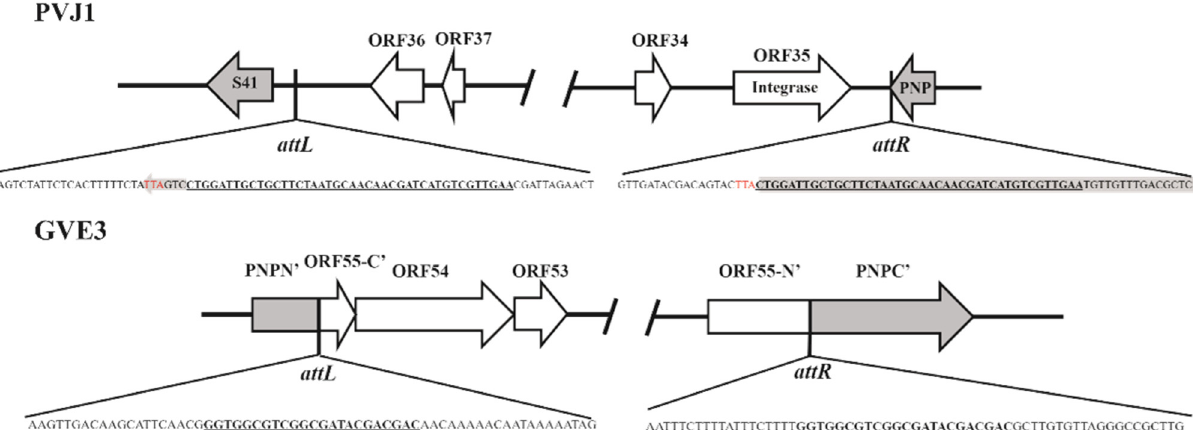
Figure 7. Sites of integration by PVJ1 and GVE3. Host genes at the site of phage integration in the host genome are shown with grey arrows. The attL and attR sequences are underlined. The stop codons are in red. The gene sequences encoding the purine nucleoside phosphorylase of Psychrobacillus sp. GC2J1 and pyrimidine nucleoside phosphorylase of G. thermoglucosidasius are in grey. PNP, purine nucleoside phosphorylase or pyrimidine nucleoside phosphorylase; PNPN’ and PNPC’ are the N- and C-terminal portions of the G. thermoglucosidasius pyrimidine nucleoside